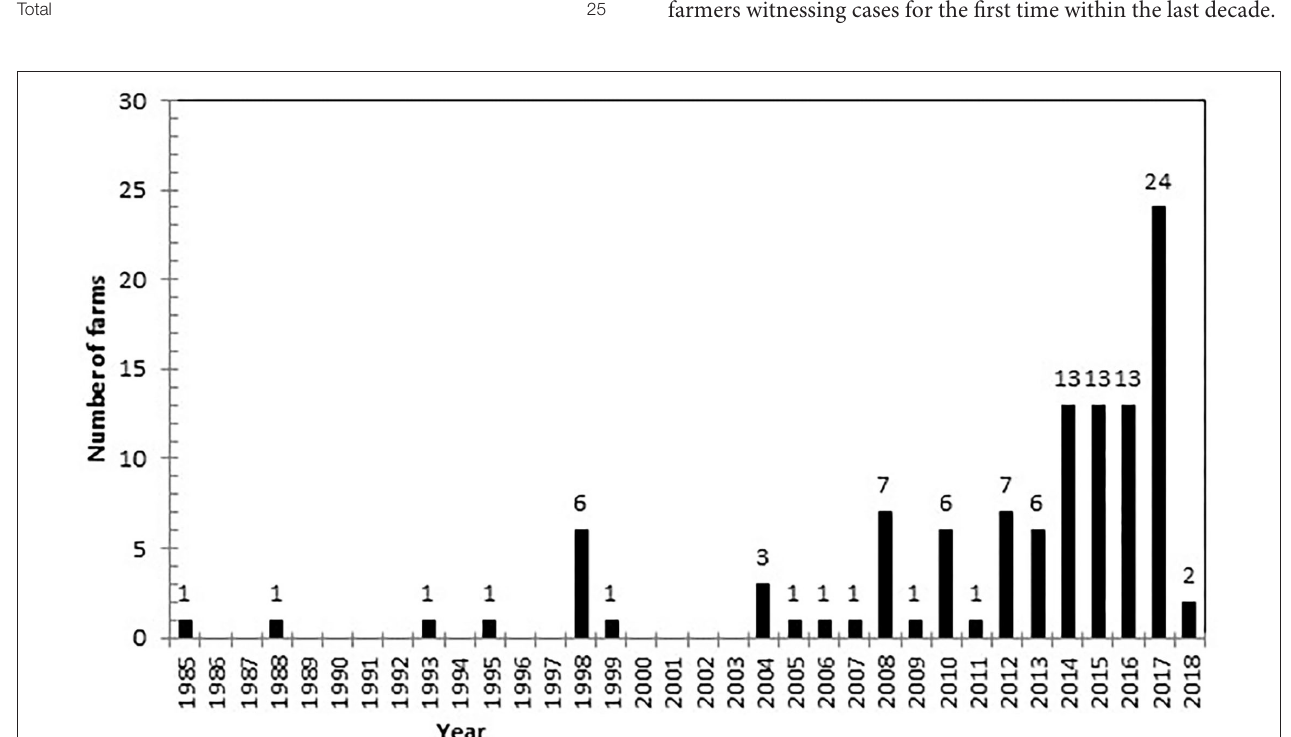
FIGURE 1 | Frequency of the year farmers reported seeing the first case of ischaemic teat necrosis (ITN) on their farm. The number of farmers reporting the first case of ITN observed on the farm is persistently higher from 2012 than earlier years. Note there are only two farms reporting the first case in 2018 as the questionnaire